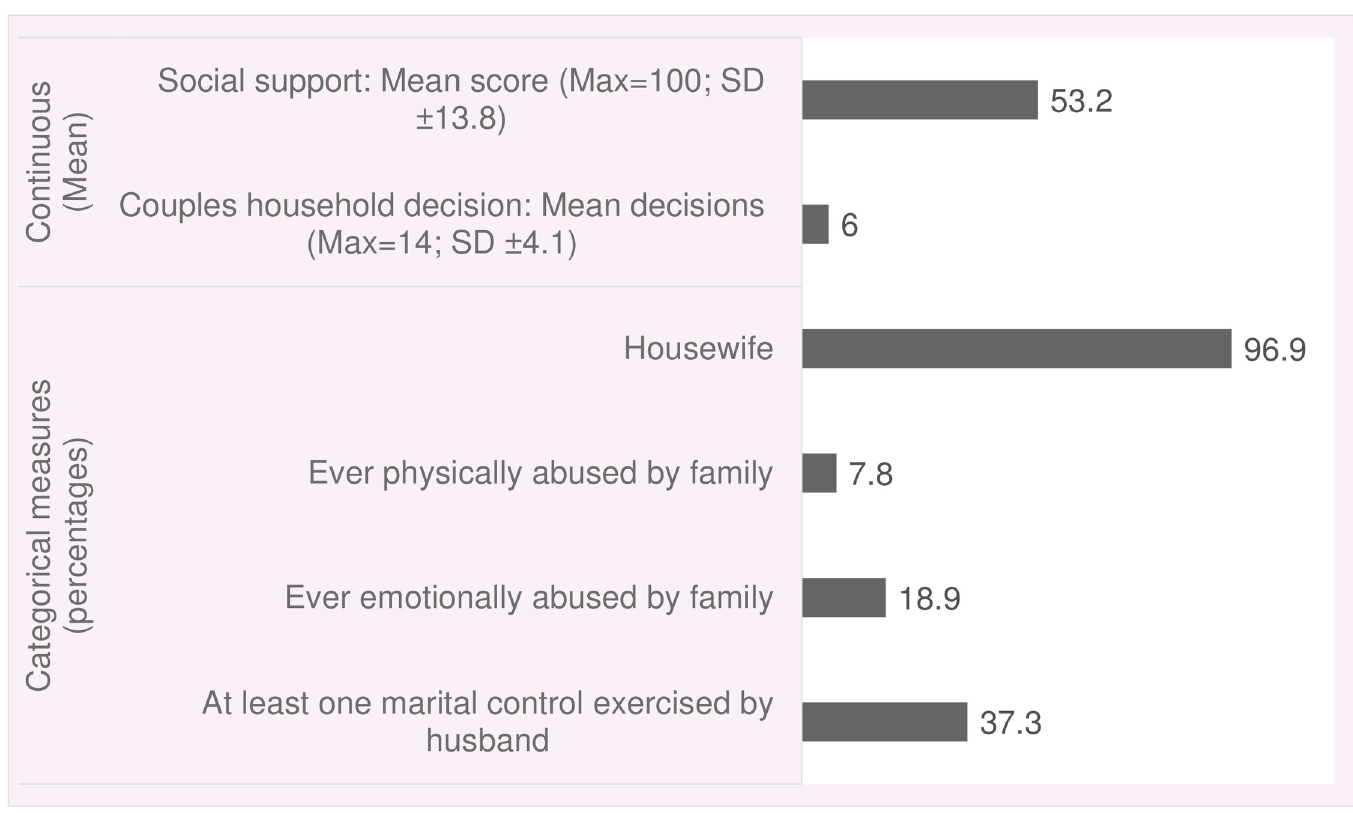
Fig 2. Measures of women’s